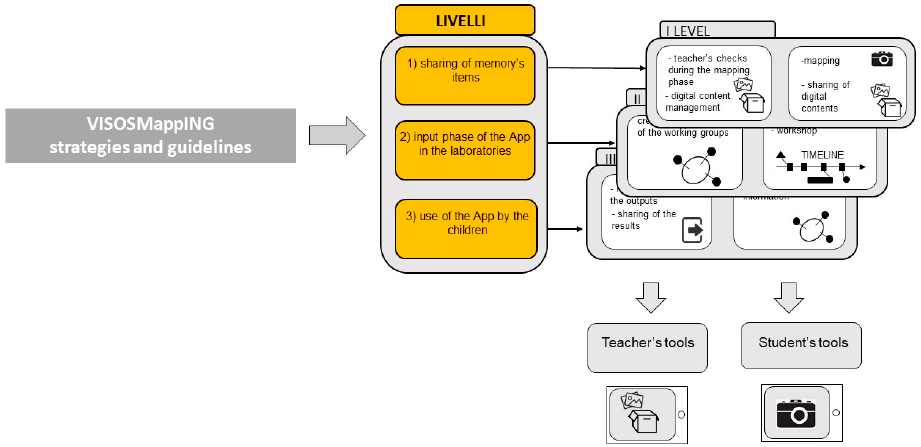
Figure 3. The app